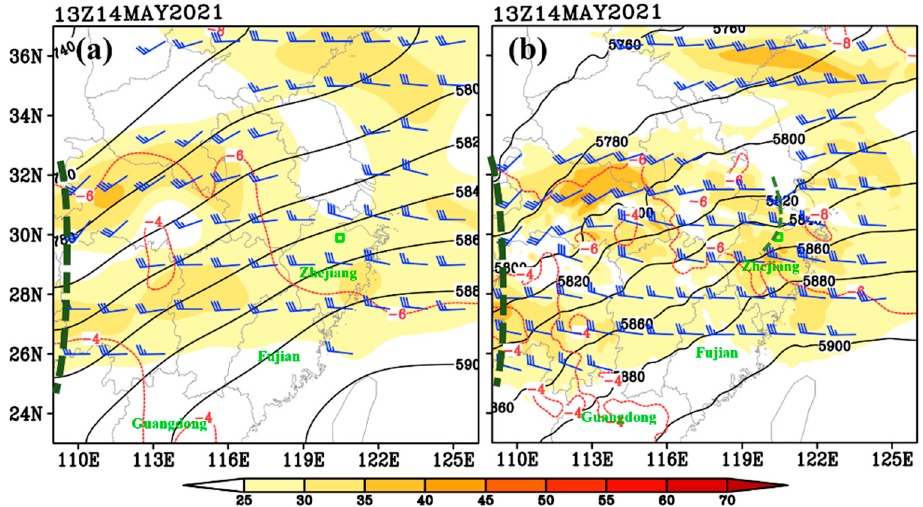
Figure 3. Panel ( a ) shows that 200 hPa wind (shading and wind barb; m s − 1 ), 500 hPa geopotential height (black contour; gpm) and 500 hPa temperature (red contour; °C) derived from ERA5 reanalysis, where the thick dashed line is the trough line and the small green boxes mark the location at which the tower toppling appeared. Panel ( b ) is the same as ( a ) but for the